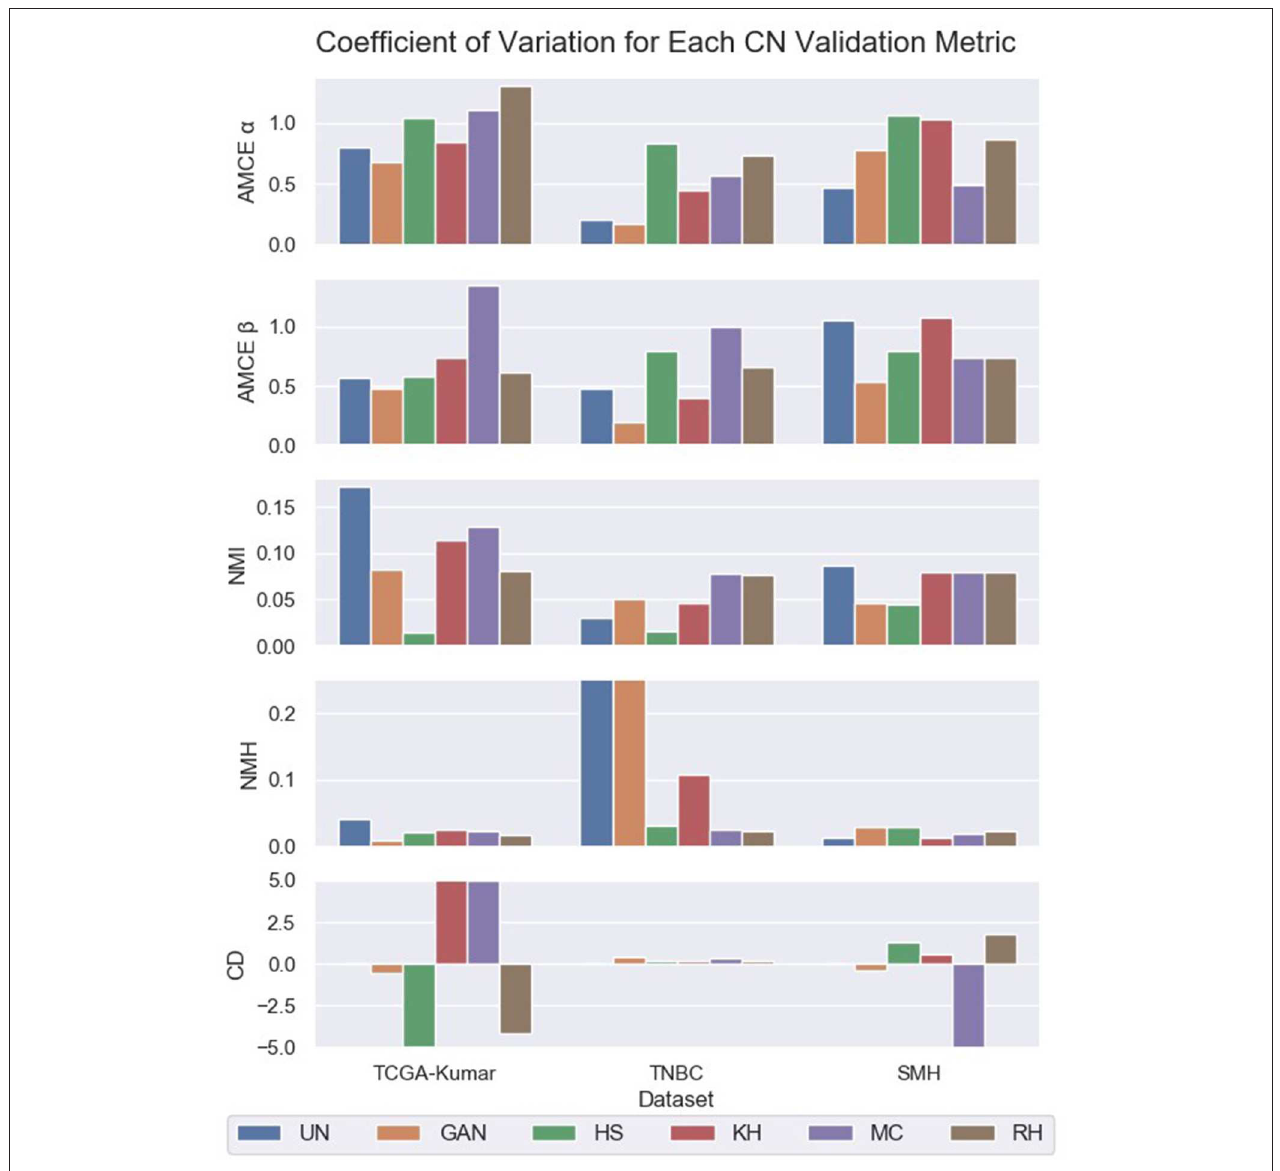
FIGURE 7 | Coefficient of variation for unormalized and color normalized